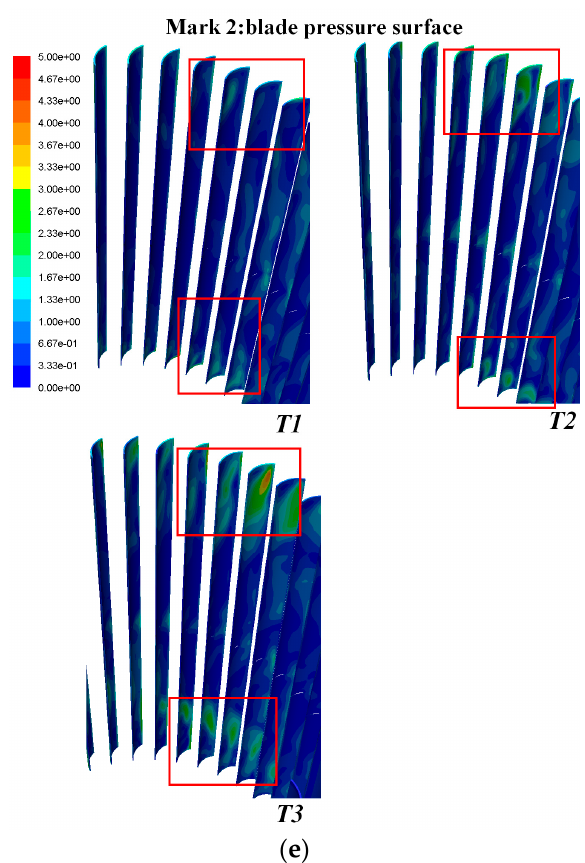
Figure 21. Skin friction coefficient of the pressure surface and suction surface of the blade.